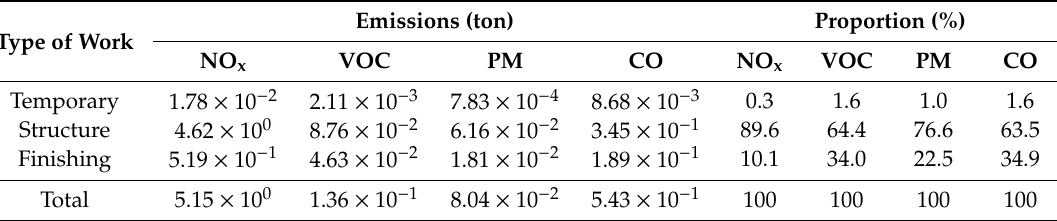
Table 3. The total pollutant emissions based on the number of vehicles registered in 2016. Type of